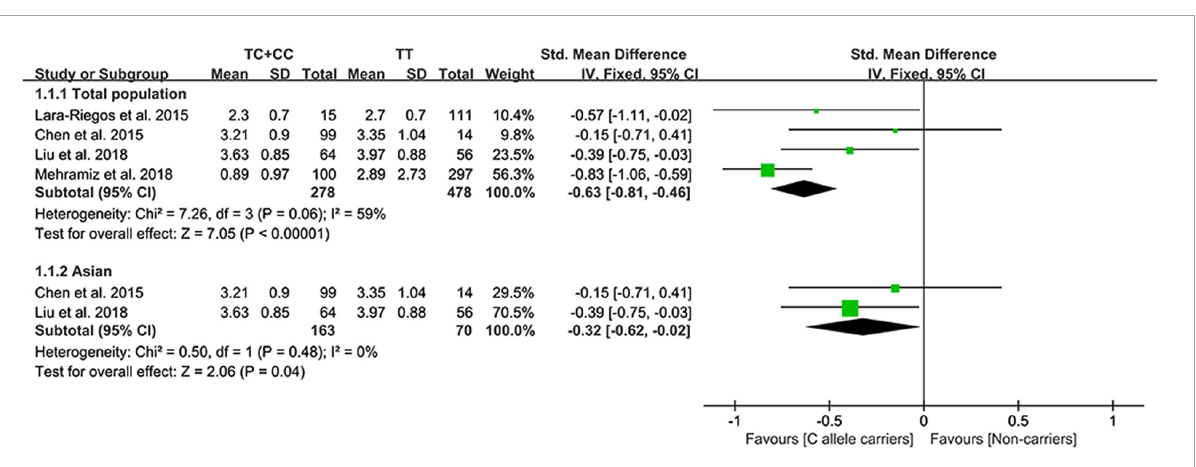
FIGURE5 A forest plot of lncRNA rs10811661 variant with circulating LDL-C